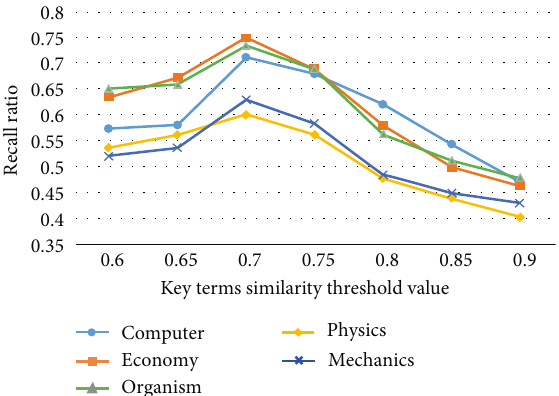
Figure 9: Recall ratio comparison of various key similarity threshold value.